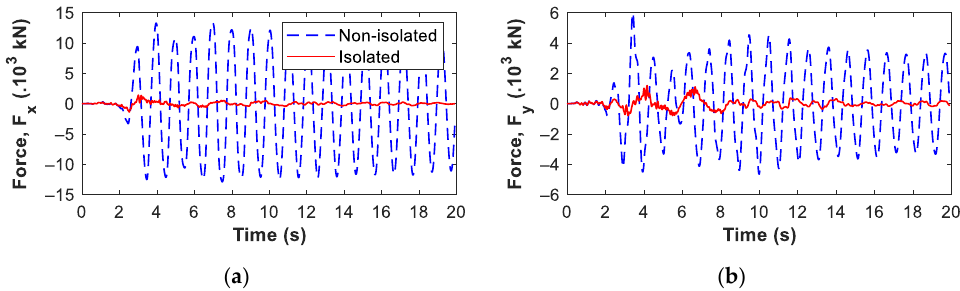
Figure 7. Time history of the 1st-floor shear force of the building subjected to Record 1: ( a ) X-response and ( b ) Y-response.